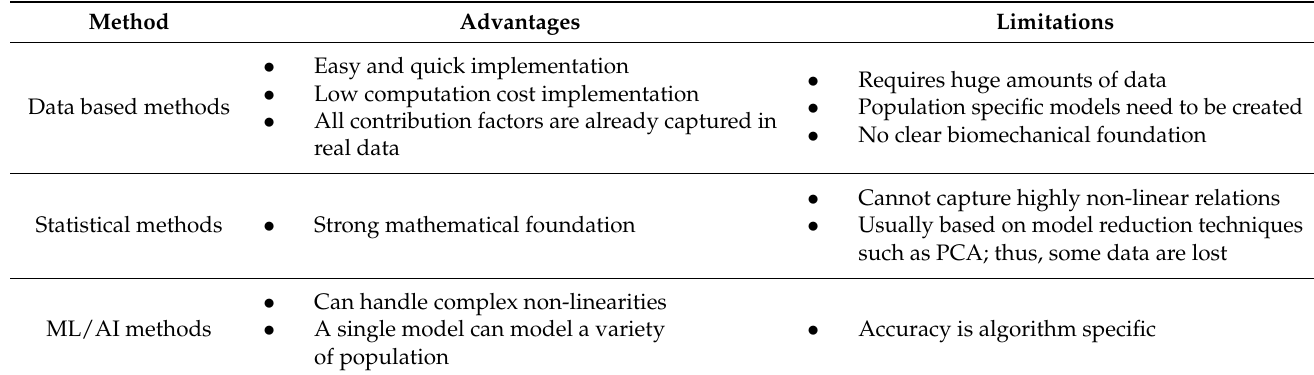
Table 2. Comparison of data-based prediction